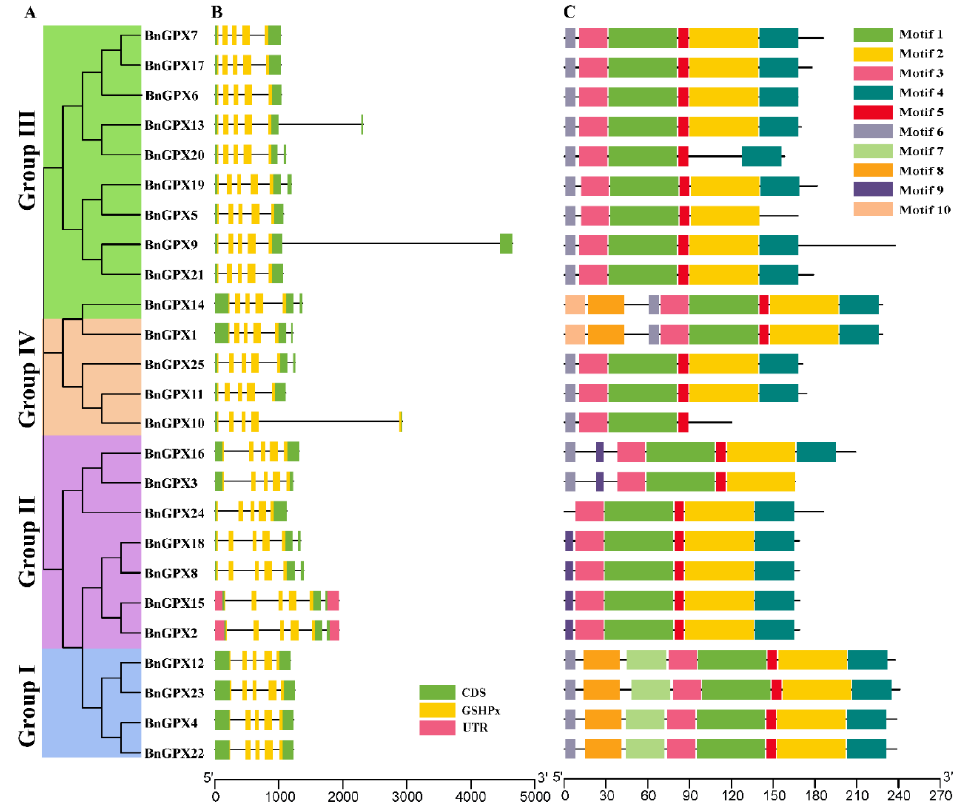
Figure 4. The gene structure and motif analysis of the GPX family genes from rapeseed. ( A ) Based on the phylogenetic interactions, the BnGPX genes are grouped into four groups (Groups I–IV). ( B ) The gene structure of the BnGPXs . Light green color indicates the CDS regions, pink color displays the UTR regions, yellow color displays the GSHPx domains, and black horizontal line demonstrates the introns. ( C ) Conserved motifs configurations are named in the BnGPXs . Unique color boxes demonstrate distinct motifs.